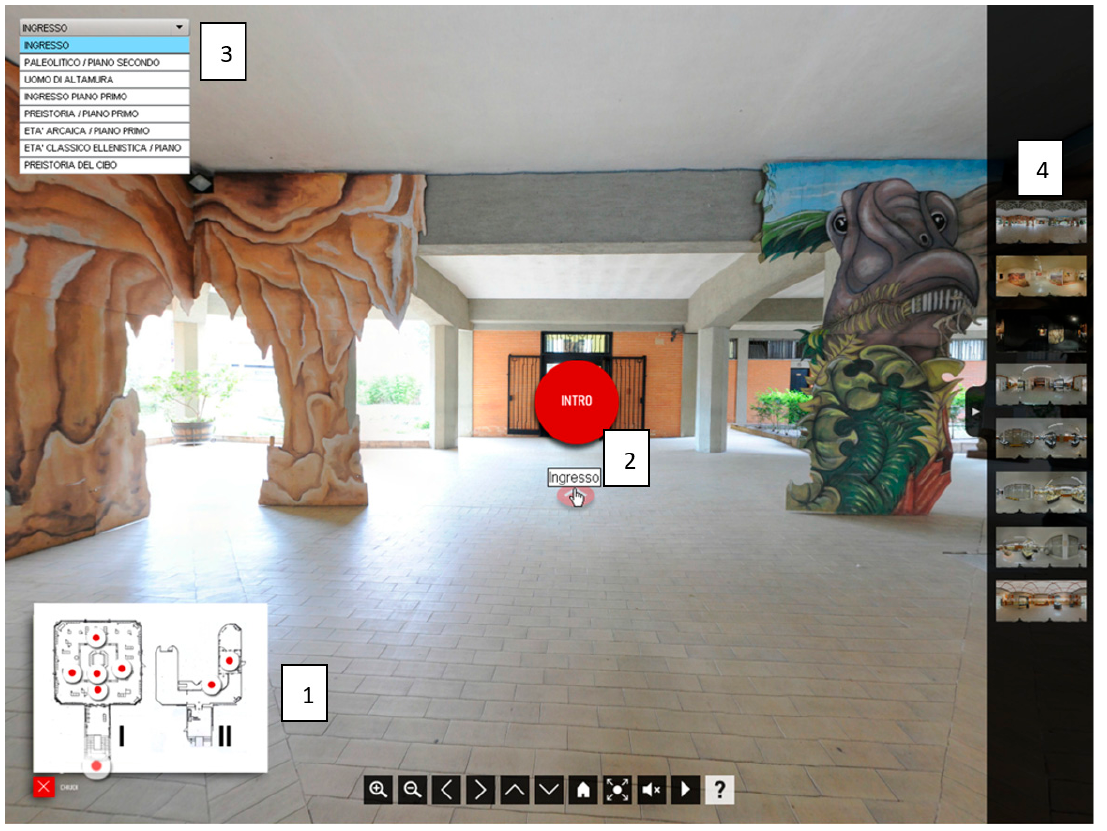
Figure 7. Virtual tour of the National Archaeological Altamura Museum. The interface shows: floor plans; scenes list and preview; link to “Paleolithic/second floor” scene (arrow with label “Ingresso”).